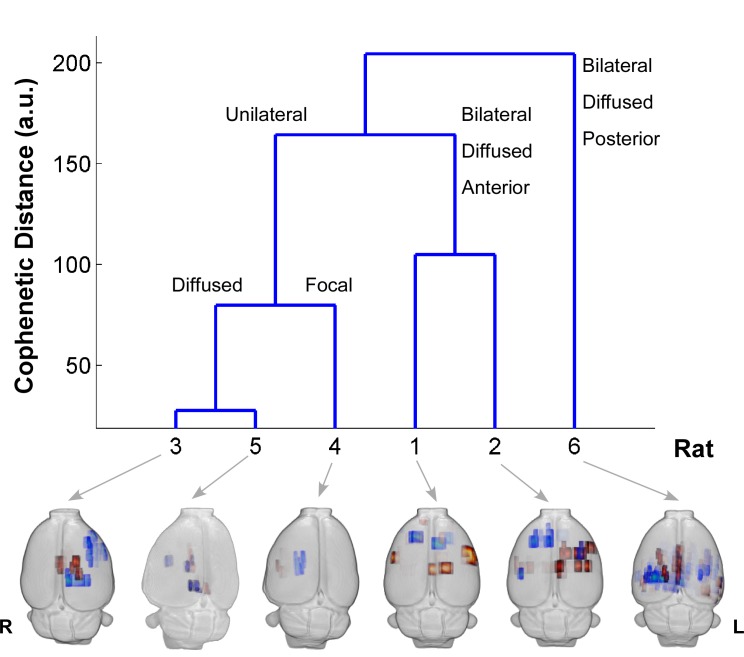
Hierarchical Clustering.The blue cluster tree is obtained using the data in Table 3 as the input for hierarchical clustering. The height of the cluster tree is the cophenetic distance between two different classes in an arbitrary unit. The horizontal axis is the rat number. All the labels on the top of the blue lines represent descriptions of the common feature of the irritative zone distribution within each class. The 3-D BOLD response maps of the distribution of irritative zones obtained from these six rats are displayed below the cluster tree. R = right; L = left; BOLD = blood-oxygen-level dependent.